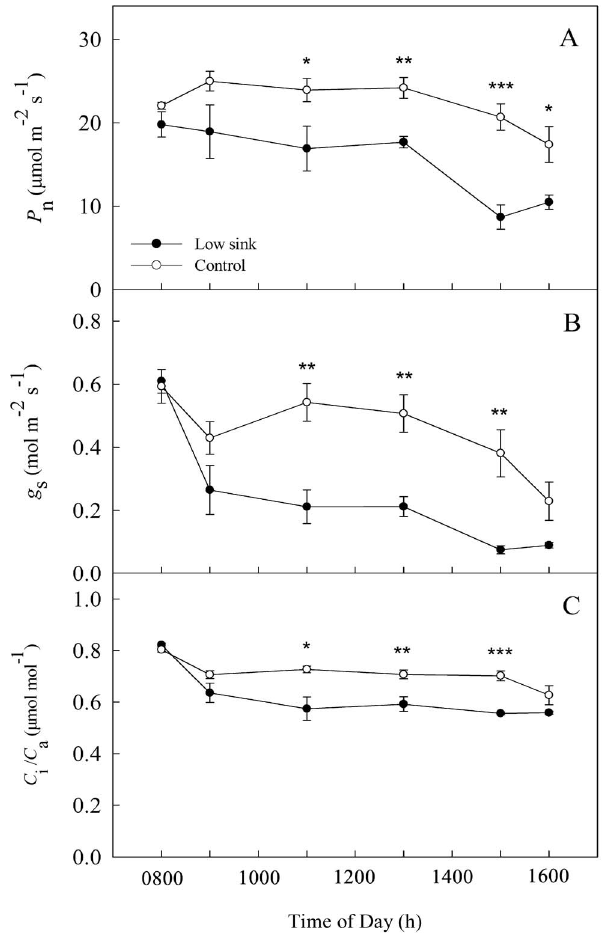
Figure 1. Diurnal variation in gas exchange parameters, including net photosynthesis rate ( P n ), stomatal conductance ( g s ) and internal-to-ambient CO 2 concentration ratio ( C i / C a ) in bean source leaves in response to low sink demand on the 1 st day after removing the sink of roots and pods. Each value represents the mean of five replicates, and error bars represent 6 S.E. The asterisks *, ** and *** indicate significant difference at P , 0.05, 0.01 and 0.001 between the control and low sink,